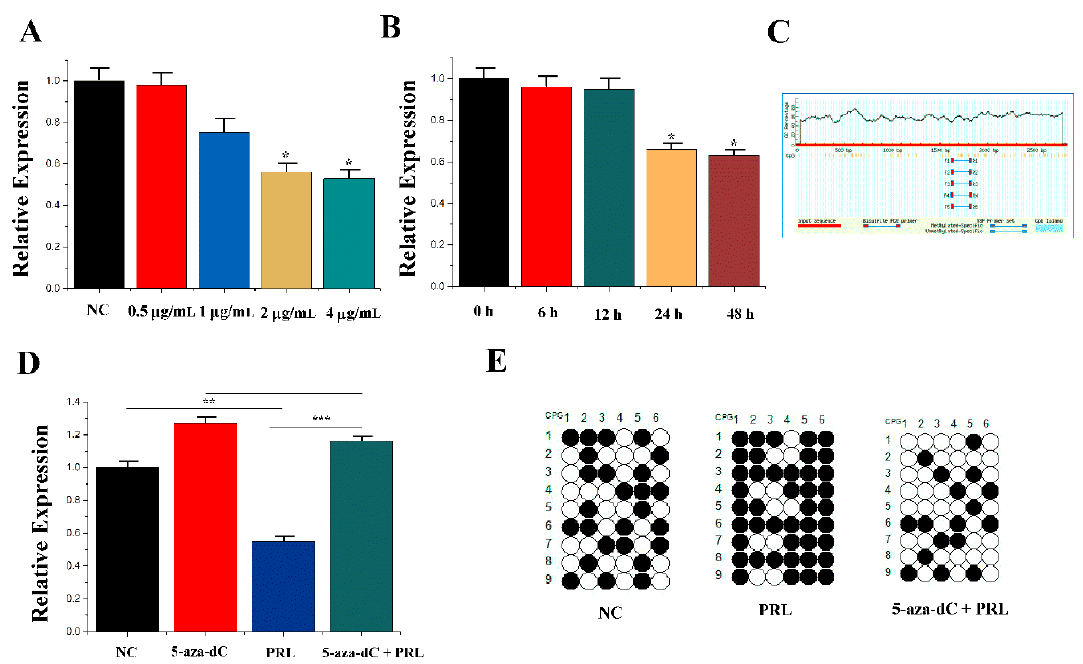
Figure 2. PRL affecting miR-183 expression. ( A ) The expression of miR-183 in CMEC treated with PRL for 48 h. ( B ) The expression of miR-183 after incubation with 2 µg/mL PRL. ( C ) CpG islands are present in the miR-183 promoter region. ( D ) The miR-183 expression levels in CMECs transfected with NC, 5-aza-Dc, PRL, and PRL +5-aza-dC. ( E ) Bisulfite DNA sequencing of CMECs transfected with NC, PRL, and PRL + 5-aza-dC. Values are presented as means ± standard deviation, * p < 0.05; ** p < 0.01; *** p < 0.001.